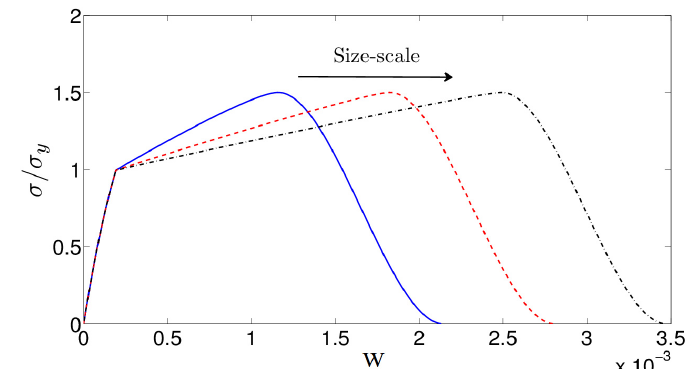
Figure 6. Hardening cohesive laws obtained from the results in Figure 4, for different specimen size-scales (the inelastic displacement w is measured in